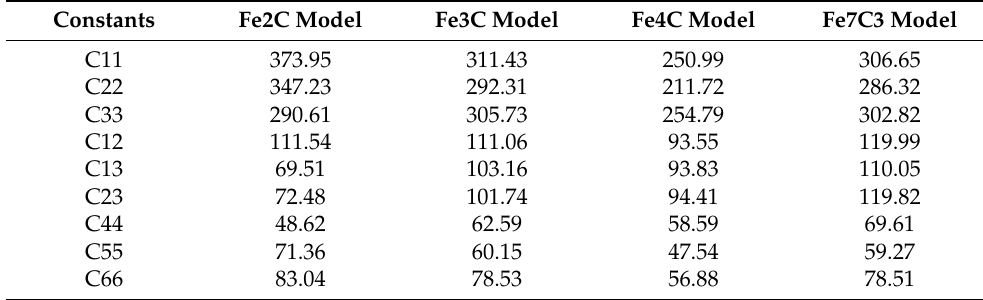
Table 4. MD-calculated elastic constants of the ferrite–carbide models (unit: GPa).